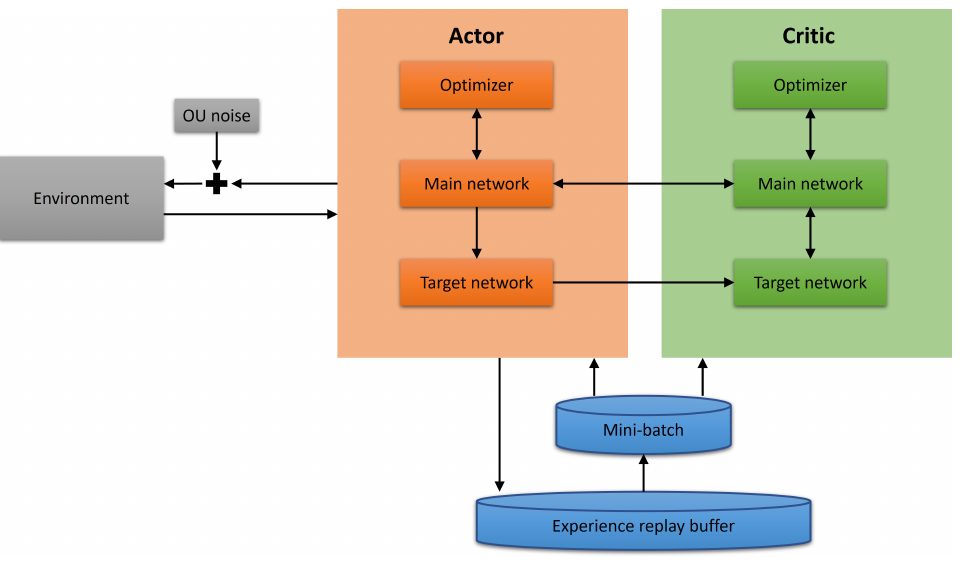
Figure 2. The DRL